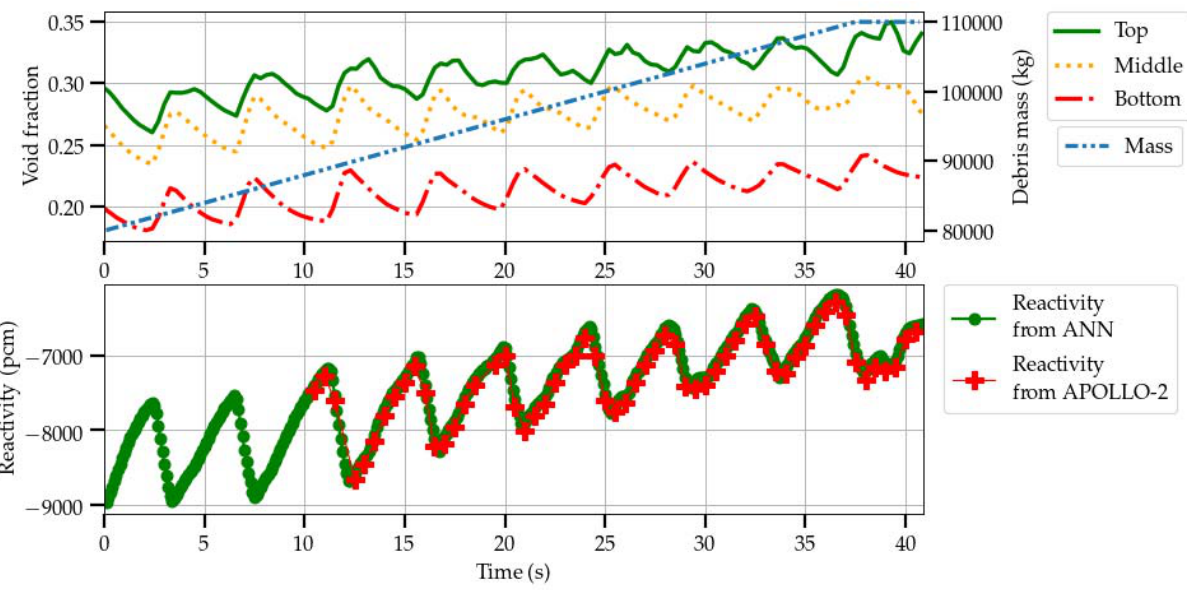
Figure 6: Top: Void fraction with increasing debris mass. Bottom: validation of the ANN with respect to APOLLO2 for the evolution of the system